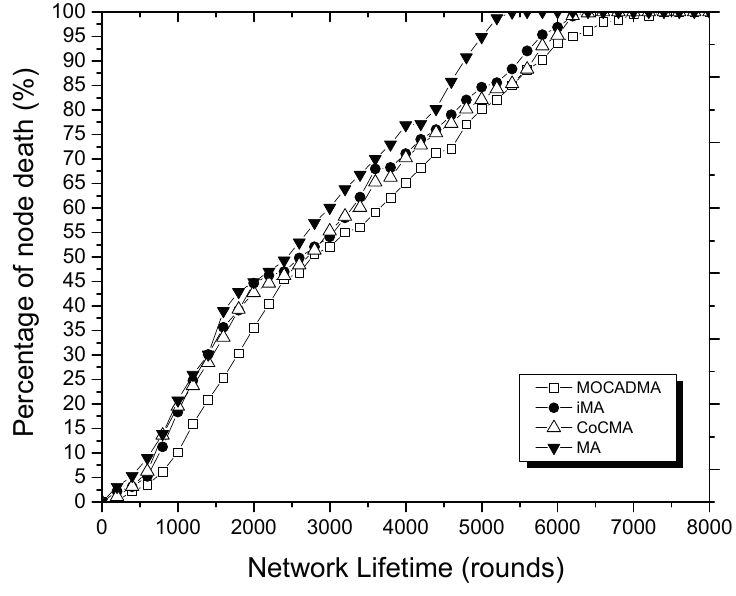
Figure 8. Percentage of node death versus network lifetime in rounds.